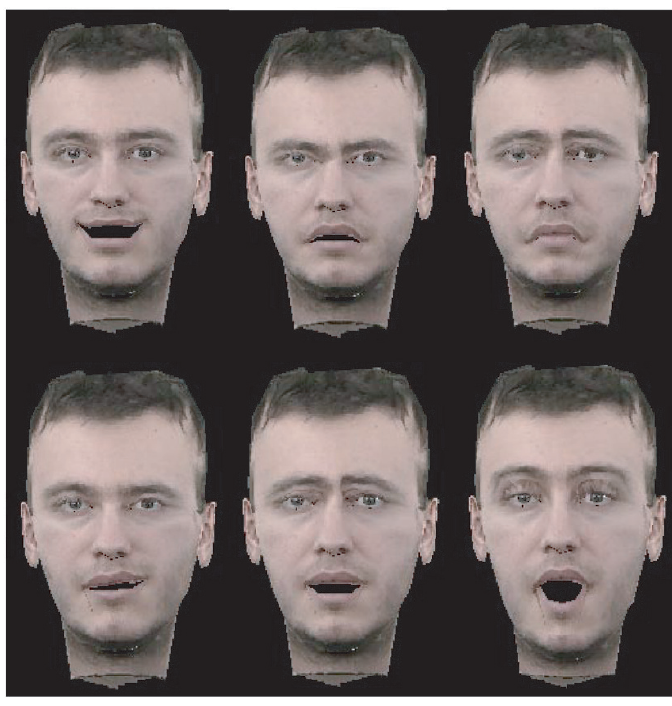
Figure 18: MPEG-4 emotions on Nikolas test